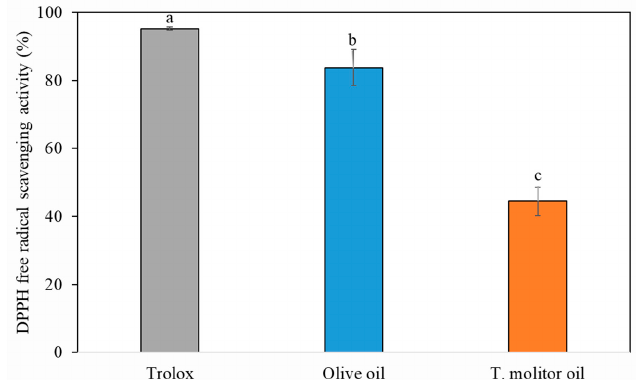
Figure 1. Antioxidant activities of Trolox, olive oil, and Tenebrio molitor oil (means with different letters on bars indicate significant differences at p < 0.05).